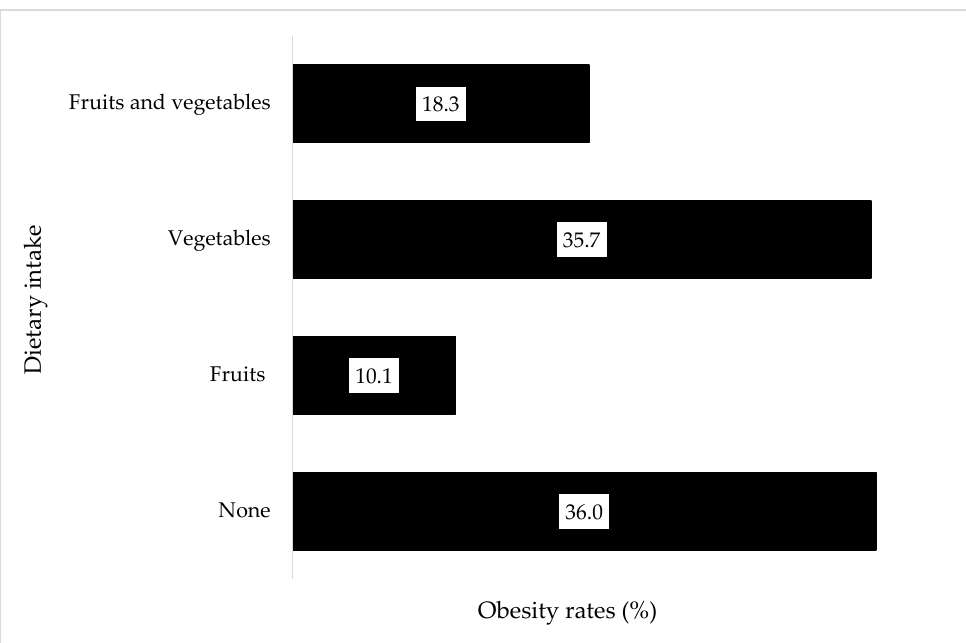
Figure 2. Obesity prevalence for any fruit or vegetable consumption across both Crossroads studies (2003–2018) Prevalence of obesity in those who consumed no fruit or vegetable, those who consumed any fruit or any vegetable, and those who consumed both fruits and vegetables are shown.